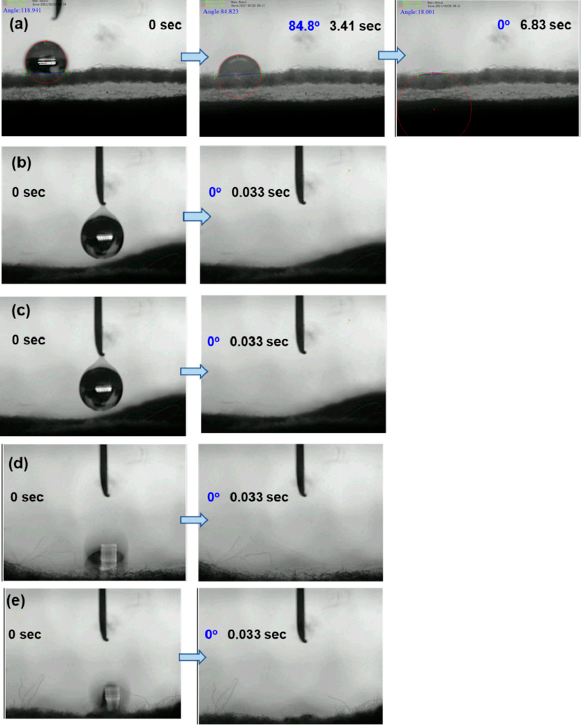
Figure 8. Dynamic contact angles of water droplets on ( a ) gauze ( b ) G/PDA ( c ) G/BWP ( d ) G/BWP/PDA ( e ) G/PDA/BWN P